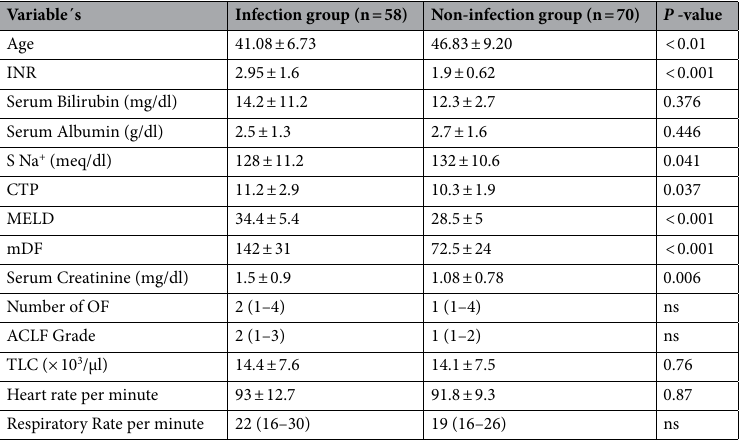
Table 1. Baseline characteristics of patients in severe alcoholic hepatitis with Infection vs non-infection group. Data is presented as mean ± SD. Independent samples t test used, p < 0.05 significant. INR international normalized ratio, CTP Child-Turcotte-Pugh Score, MELD Model for End Stage Liver Disease, mDF Maddrey’s Discriminant Function, OF organ failure, ACLF acute on chronic liver failure, TLC total leukocyte